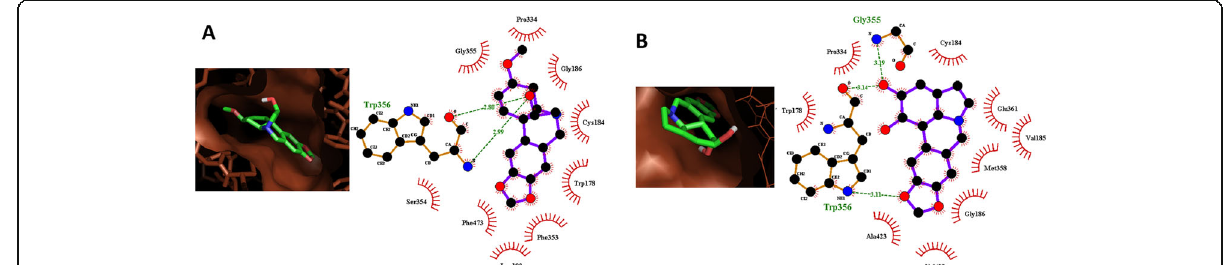
Fig. 4 The binding configuration of C. glaucum phytoconstituents and interaction analysis. Binding poses of a Crinamine and b Lycorine on NOS